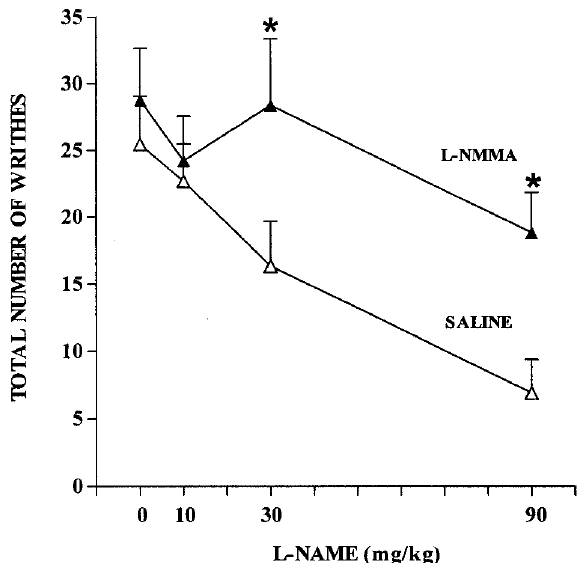
FIG. 1. Inhibition by L-NMMA (10mg/kg, i.p.) of the anti- nociceptive effect of intraperitoneal administration of L-NAME on the acetic acid writhing test in mice. The symbols are the mean ± SEM of 6–12 mice/group. *indicates sig- nificant differences ( P < 0.05) in comparison with the control L-NAME group treated with intraperitoneal saline.